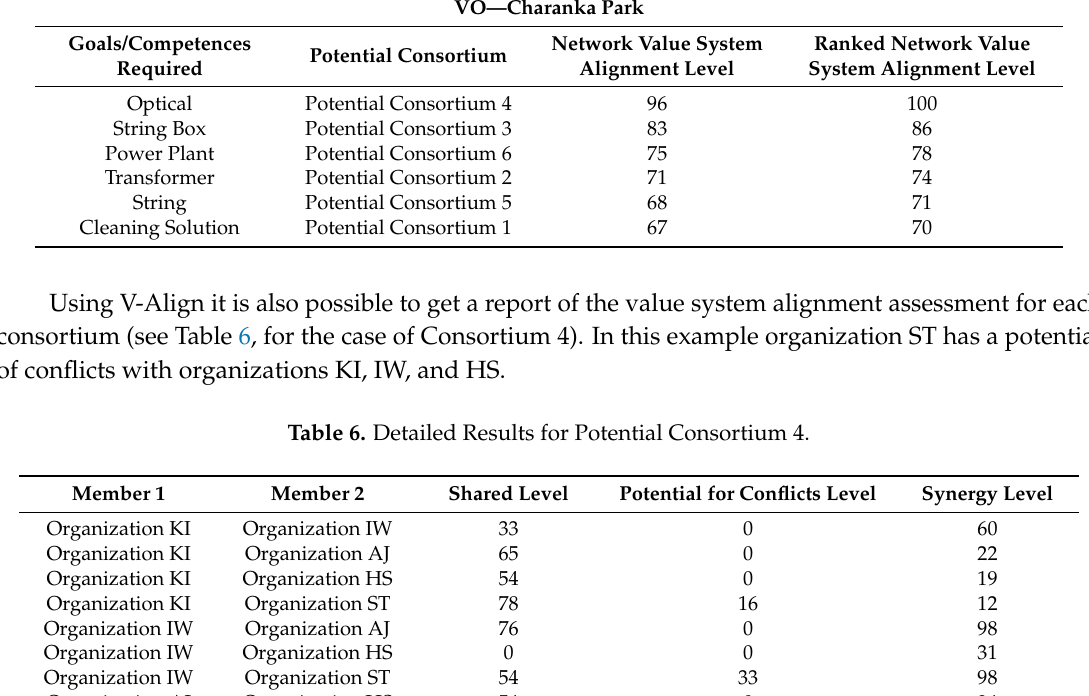
Table 5. VO’s Goals and Potential Consortia. VO—Charanka Park